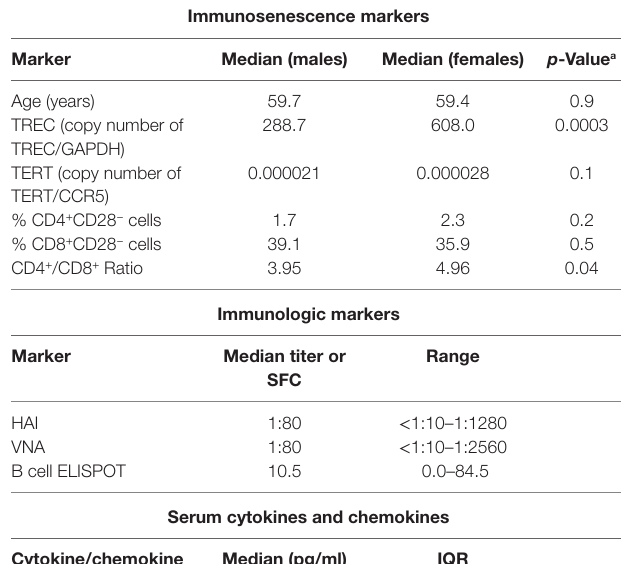
Table 1 and Figure S1 in Supplementary Material. Female study subjects had significantly higher TREC levels ( p = 0.0003) and an increased CD4 + /CD8 + ratio ( p = 0.04) ( Table 1 ). Correlations among these immunosenescence markers were weak, with two exceptions: a negative correlation, r = − 0.33, between TREC and the %CD8 + CD28 − cells; and a positive correlation, r = 0.49, between the %CD4 + CD28 − cells and the %CD8 + CD28 −